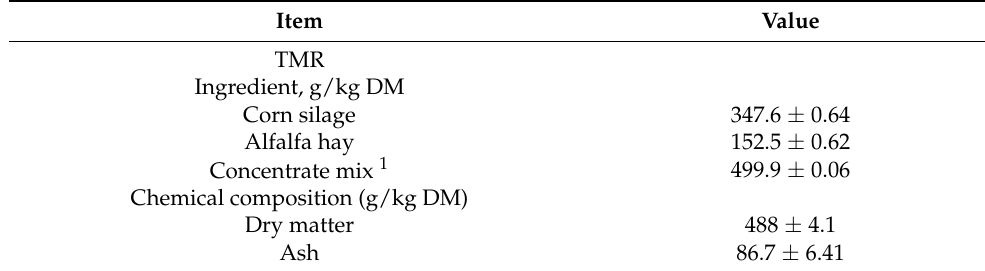
Table 1. Chemical composition of feed ingredients of the total mixed ration (TMR) used to feed lactating dairy cows (Least squares mean ± SE #